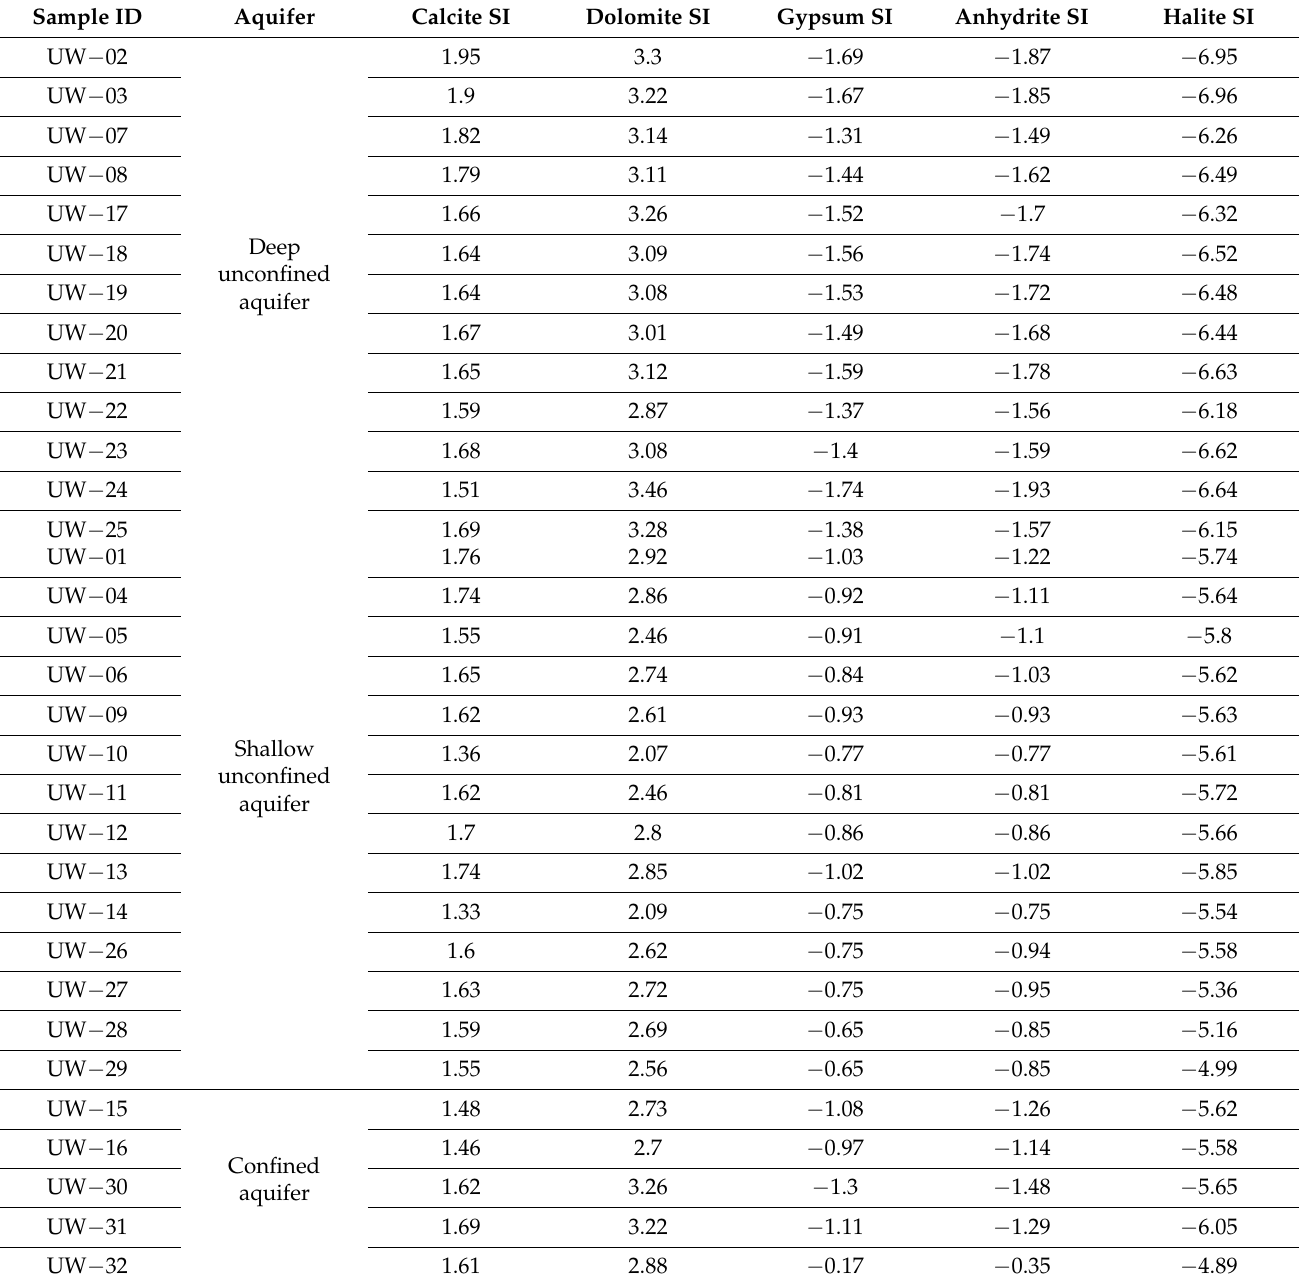
Table 3. Saturation indices (SI) of carbonate and evaporate minerals for the tested groundwater